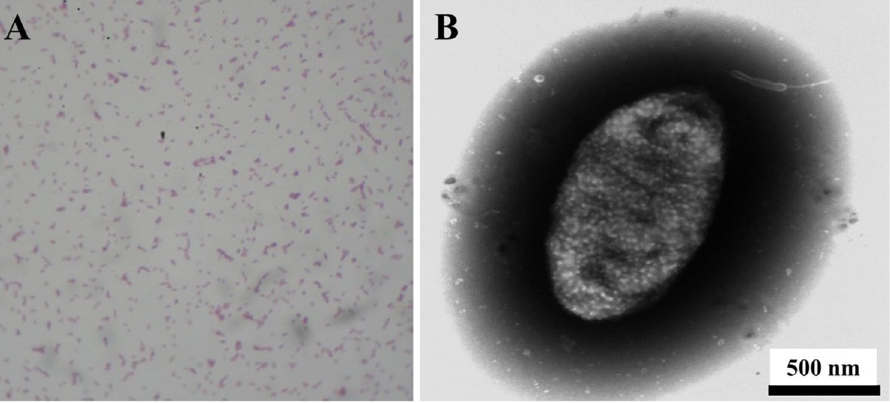
Figure 1. ( A ) The image of crystal-violet staining assay of LH-3 and ( B ) the TEM image of a single LH-3 cell.